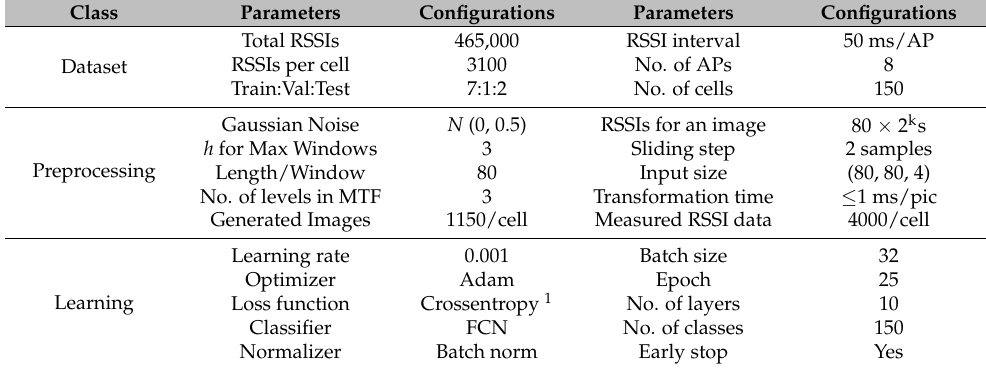
Table 1. Description of the hyperparameters for training our